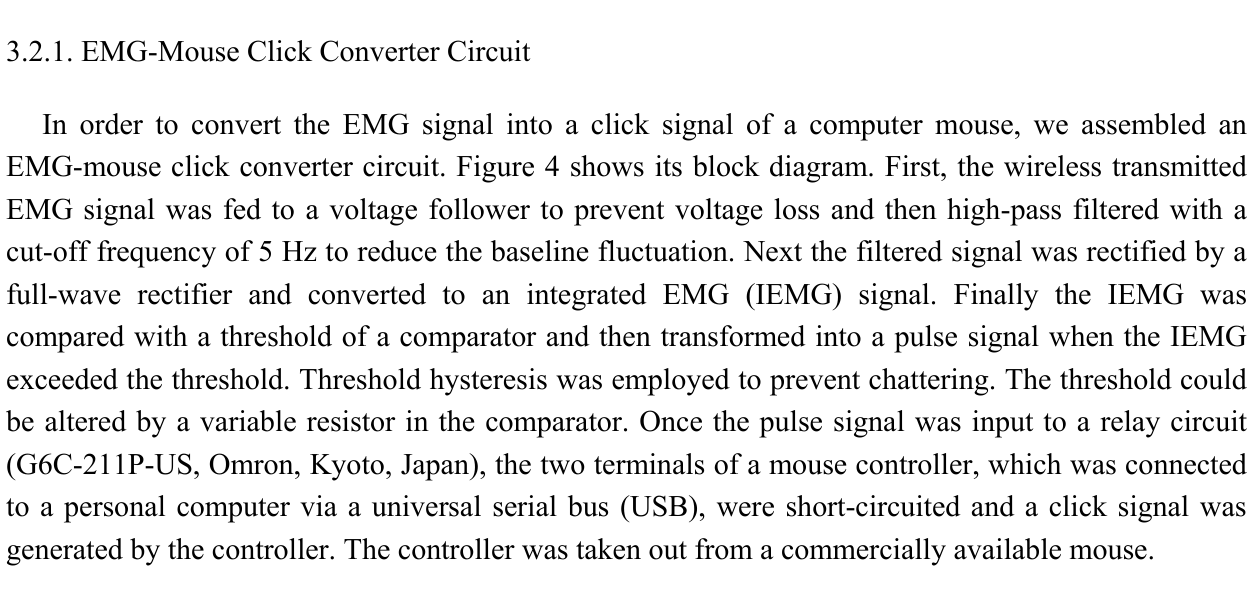
Figure 4. Block diagram of the assembled EMG-click converter